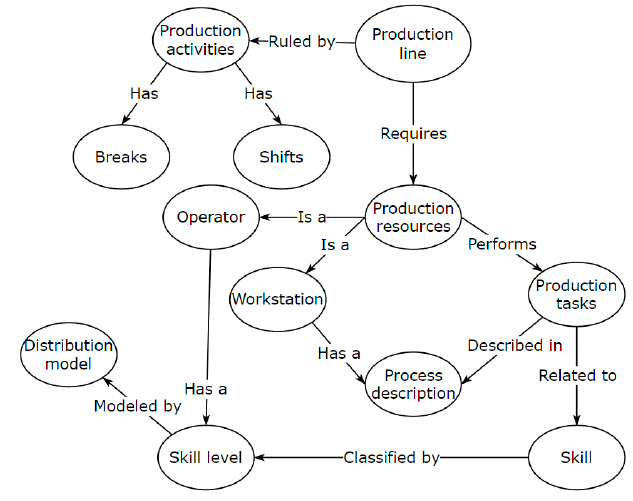
Figure 1. Shopfloor—human scheduling DT relations diagram.